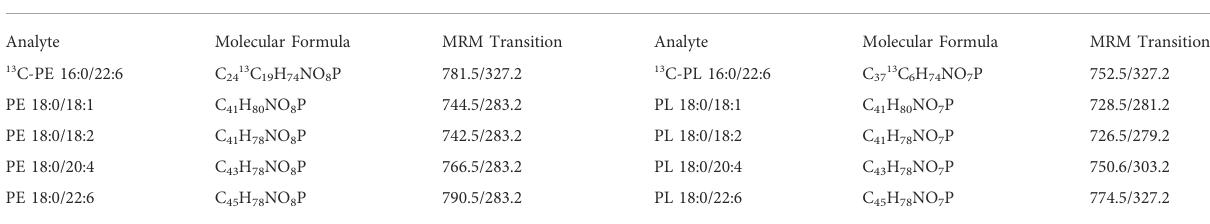
TABLE 2 MRM transitions used for ethanolamine